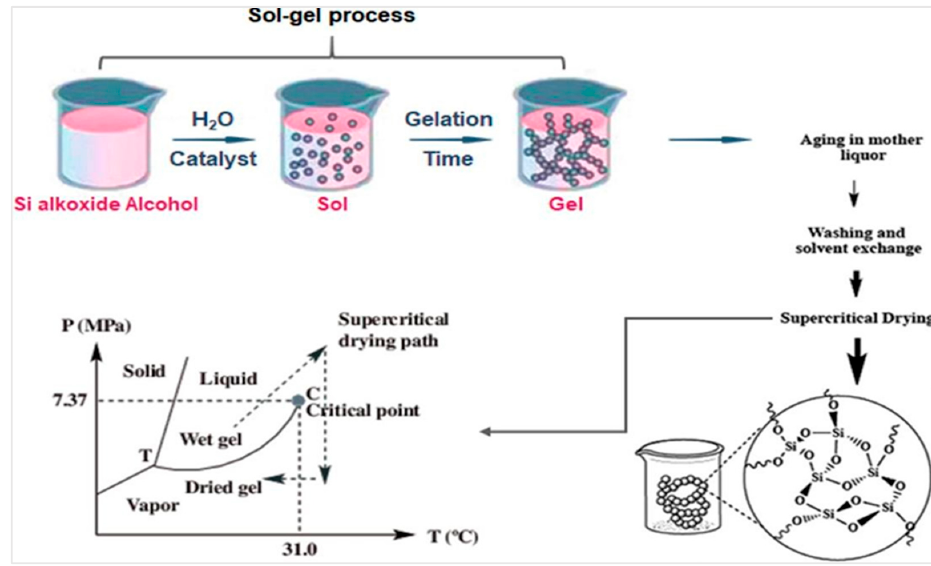
Figure 3. Schematic route of typical sol–gel synthesis [51].